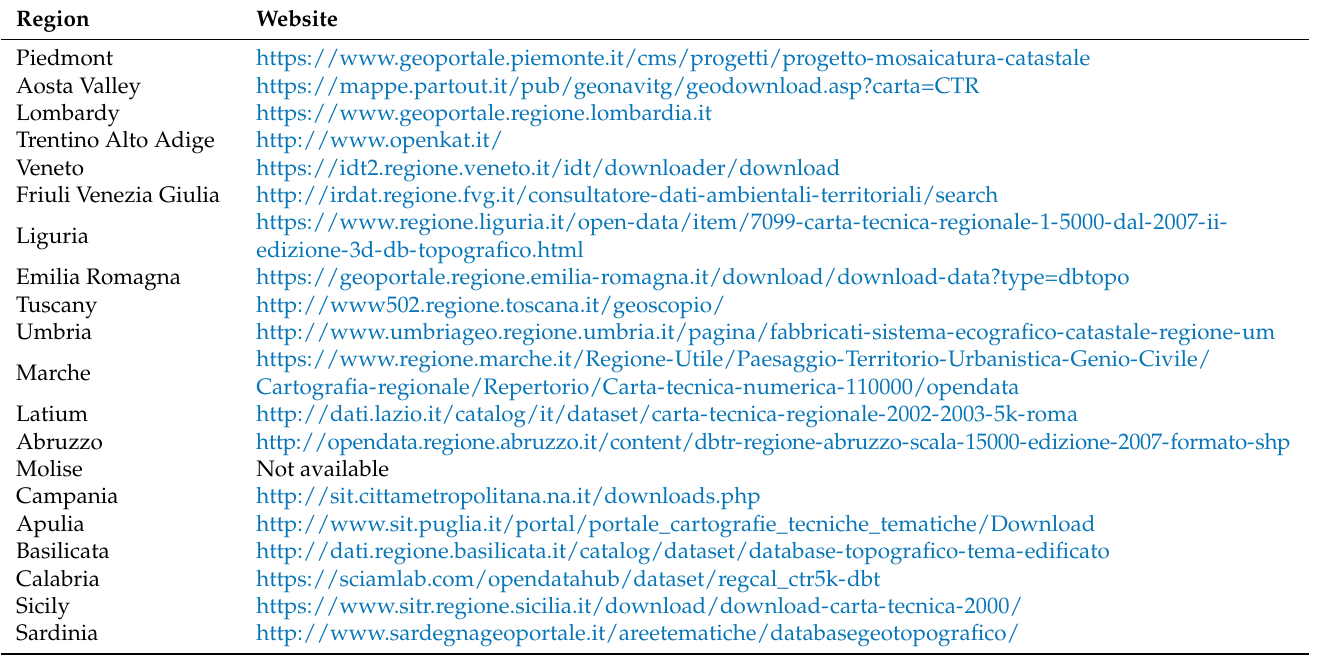
Table 1. List of administrative sources used for the construction of the BODA (last access on 10 November